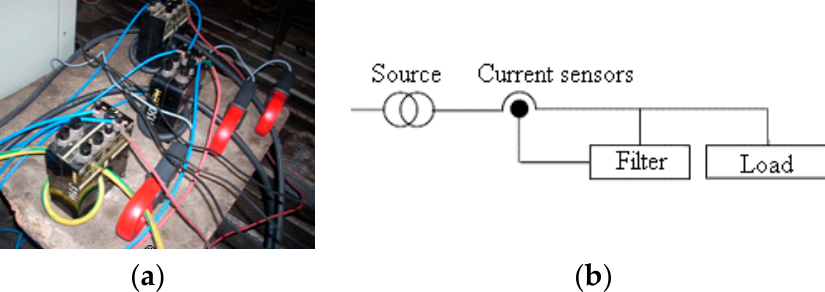
Figure 7. Simplified schematic with the data acquisition system the active filter, three ‐ phase, Recti ‐ fier, and load (chopper + D.C. motor + asynchronous generator).